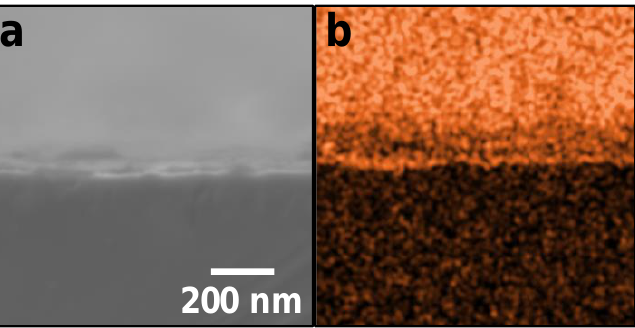
Figure 3. SE image and corresponding EDX elemental analysis of SiO 2 ‑coated substrate: ( a ) SE image and ( b ) elemental map of Si (orange) of cross‑section of substrate after one SiO 2 ‑coating, respectively.